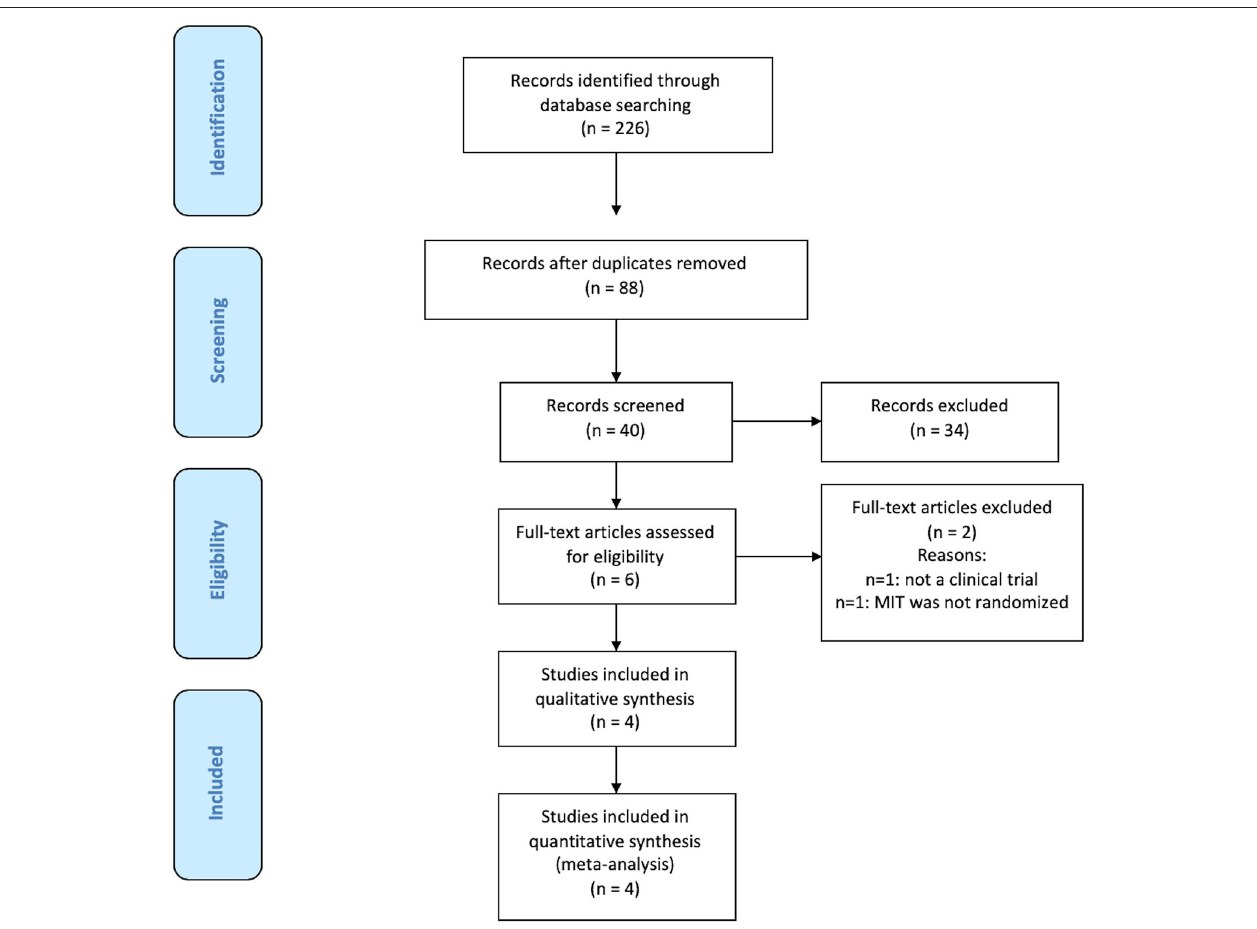
FIGURE 1 | Flowchart of the selection of eligible